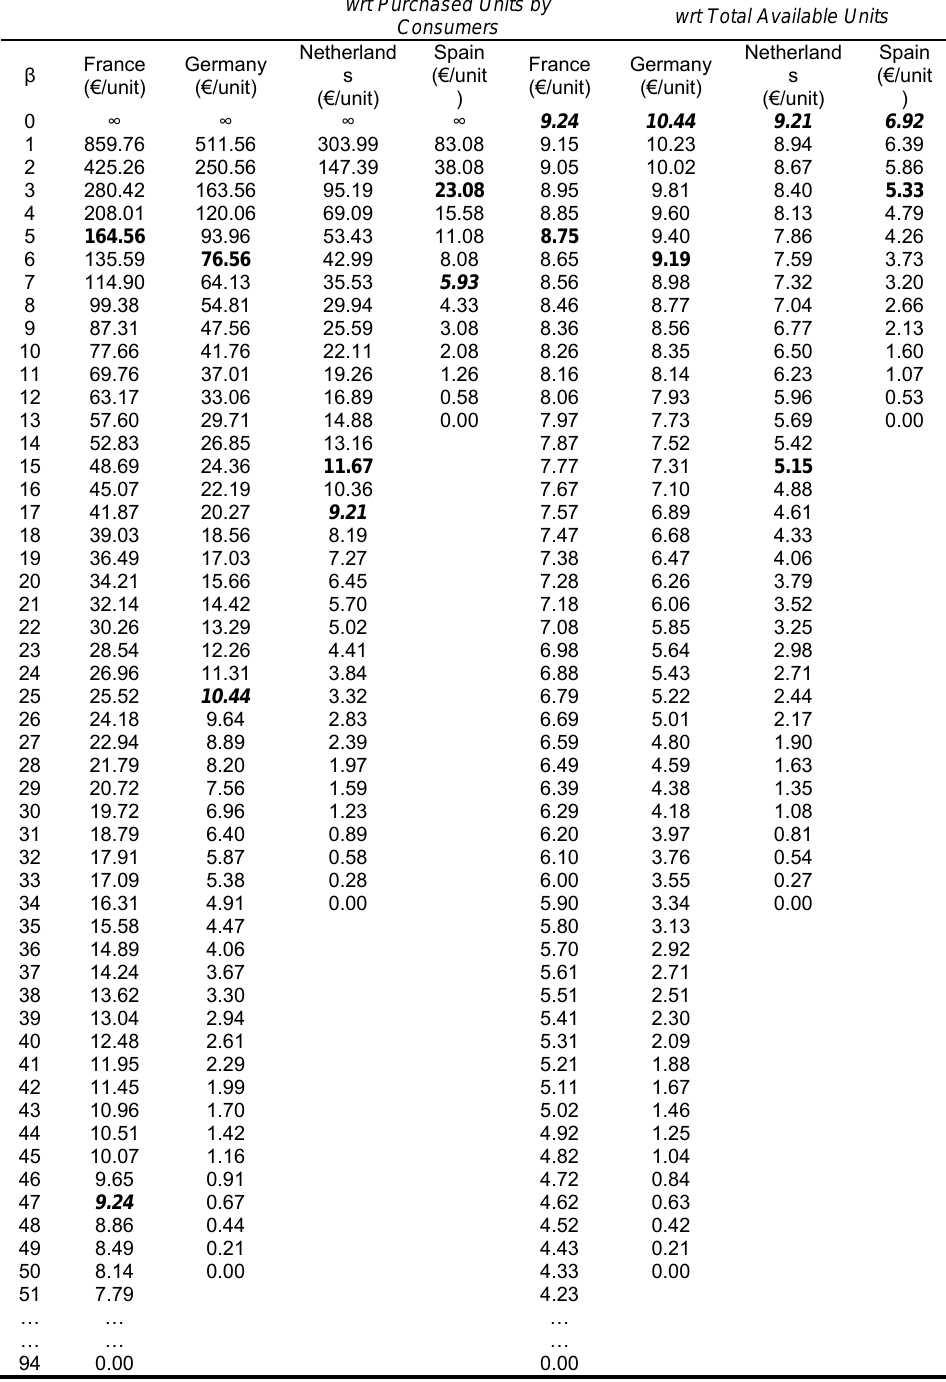
Table 6: Effective Government Cost per Unit (dependent on the chosen  )